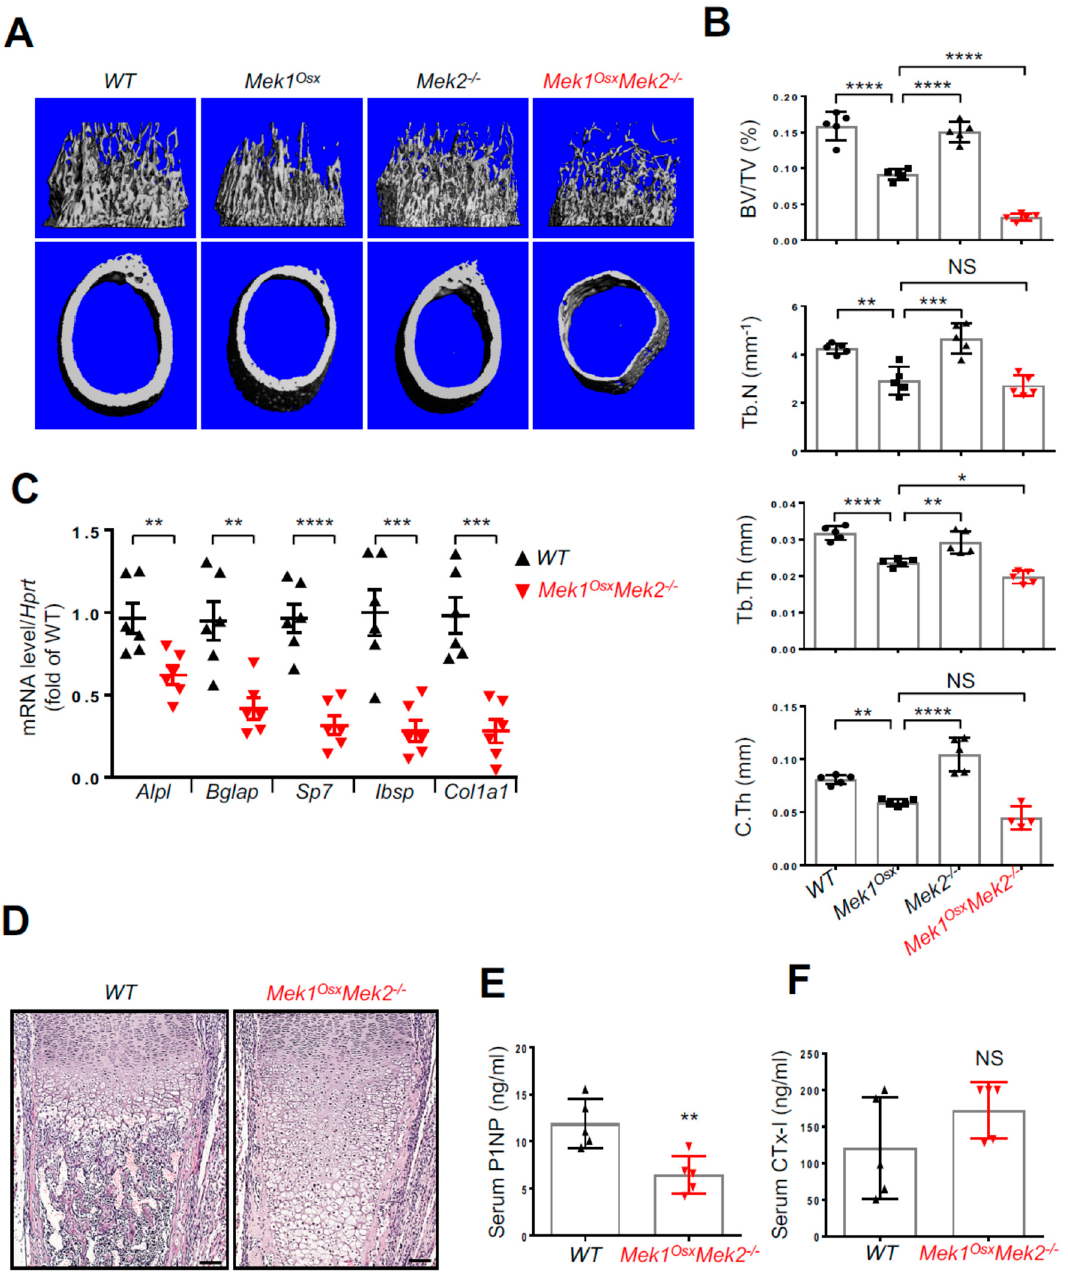
Figure 3. Inactivation of ERK in osteoprogenitors causes severe osteopenia in long bones. ( A,B ) MicroCT analysis of three-week-old WT, Mek1 Osx , Mek2 − / − , and Mek1 Osx Mek2 − / − femurs. Representative 3D-reconstruction images of trabecular (upper) and cortical bone (lower) are displayed ( A ). Quantification of trabecular bone mass and midshaft cortical bone thickness are displayed ( B ). Trabecular bone volume / total volume (BV / TV), trabecular thickness (Tb.Th), trabecular number per cubic millimeter (Tb.N), and cortical thickness (C.Th). ( n = 4~5). ( C ) Total RNAs were isolated from three-week-old WT and Mek1 Osx Mek2 − / − tibias, and mRNA levels of osteoblast di ff erentiation genes were measured by RT-PCR. ( n = 6). ( D ) H&E-stained longitudinal sections of three-week-old WT and Mek1 Osx Mek2 − / − femurs. Scale bar, 1 mm. ( E,F ) Serum levels of P1NP and CTx-I were measured by ELISA. ( n = 5). Values represent the mean ± SD.; NS, not significant, * p < 0.05, ** p < 0.01, *** p < 0.001, and **** p < 0.0001 by the one-way ANOVA test (B) or an unpaired two-tailed Student’s t -test (C,E,F). 2.3. Inducible Inactivation of the ERK Pathway in Osteoprogenitors Results in Osteopenia in Adult Mice